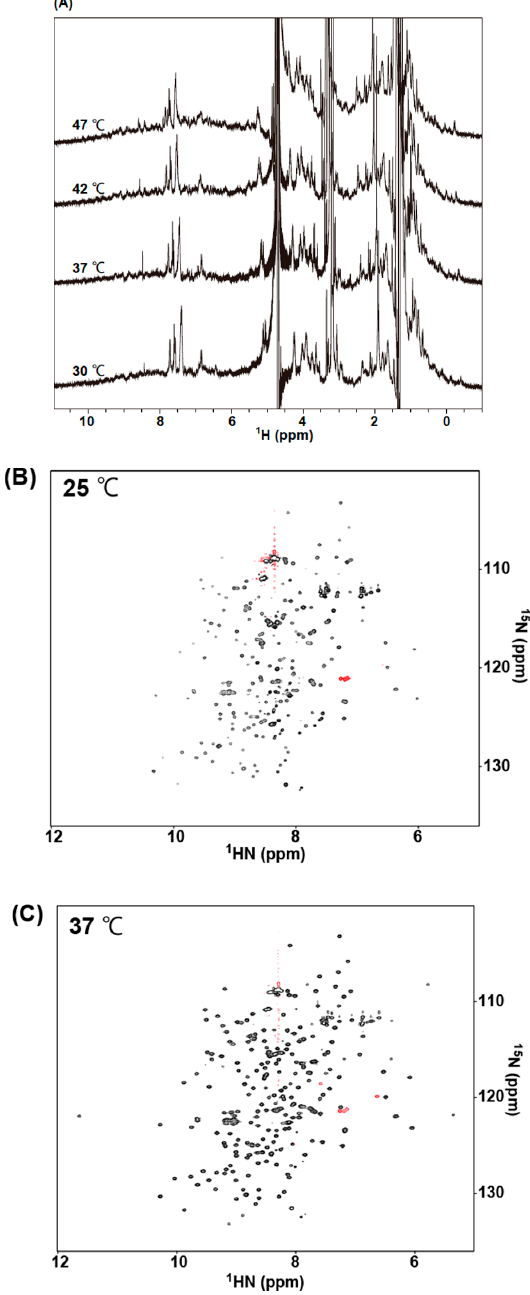
Figure 9. NMR spectra of 73MuH19. Proton 1D NMR spectra of 73MuH19 in the presence of CBZ-GA-pyridine at various temperatures ranging from 30 °C to 47 °C are shown in panel ( A ). 1 H- 15 N HSQC spectra of 73MuH19 in the presence of CBZ-GA-pyridine at 25 °C and 37 °C are shown in panels ( B ) and ( C ), respectively.